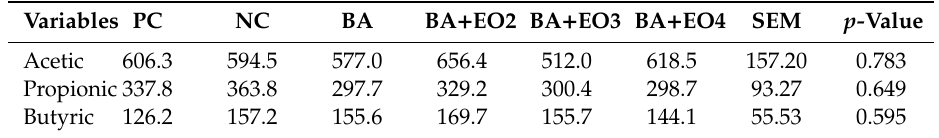
Table 6. E ff ect of experimental diets on the production of volatile fatty acids (mMol / g) in the cecum of piglets challenged with E. coli F4.